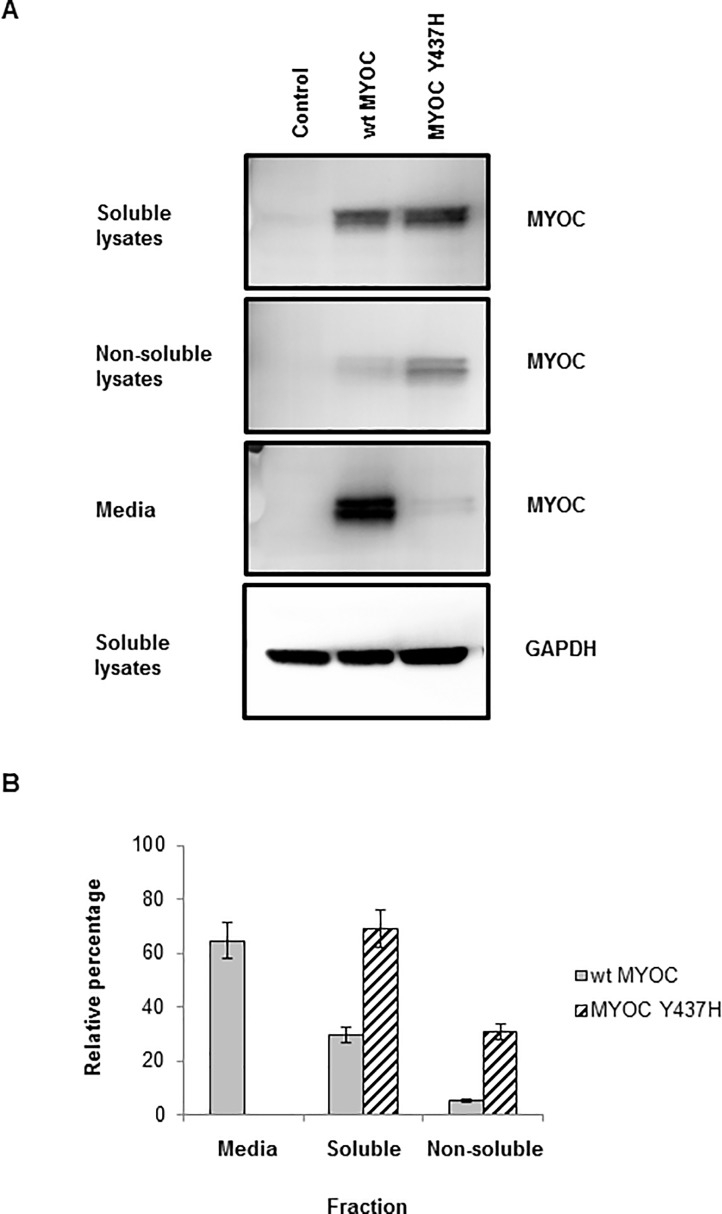
NTM5 cells transiently-transfected for 48 hours with plasmids which had MYOC cDNAs were analyzed by Western blot.(A) Wild-type (wt) MYOC is predominantly secreted while mutant CMV-MYOC-Y437H is not secreted and has a larger non-soluble fraction when compared to wt MYOC. Anti-MYOC goat antibody from R&D Systems was utilized. (B) Percentage of MYOC in each cell fraction was estimated based on Western blot band intensity. Error bars are +/-SD.